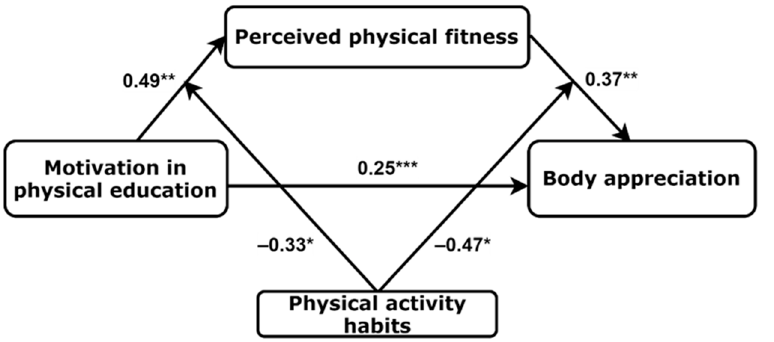
CI = confidence interval, LB = lower bound, UB = upper bound; TAS = teacher support of autonomy, MPE = moti- vation in PE, PAH = physical activity habits, PPF = perceived physical fitness, BA = body appreciation. A simplified moderated mediation model (triangle, Figure 3) in girls revealed positive associations between motivation in PE and PPF ( β = 0.49, p = 0.001), between PPF and body appreciation ( β = 0.37, p = 0.002), and between motivation in PE and body appreciation ( β = 0.25, p < 0.001). Importantly there were two significant moderated effects in this model: PA habits moderated the associations between motivation in PE and PPF ( β = − 0.33, p = 0.027) and between PPF and body appreciation ( β = − 0.47, p = 0.042).